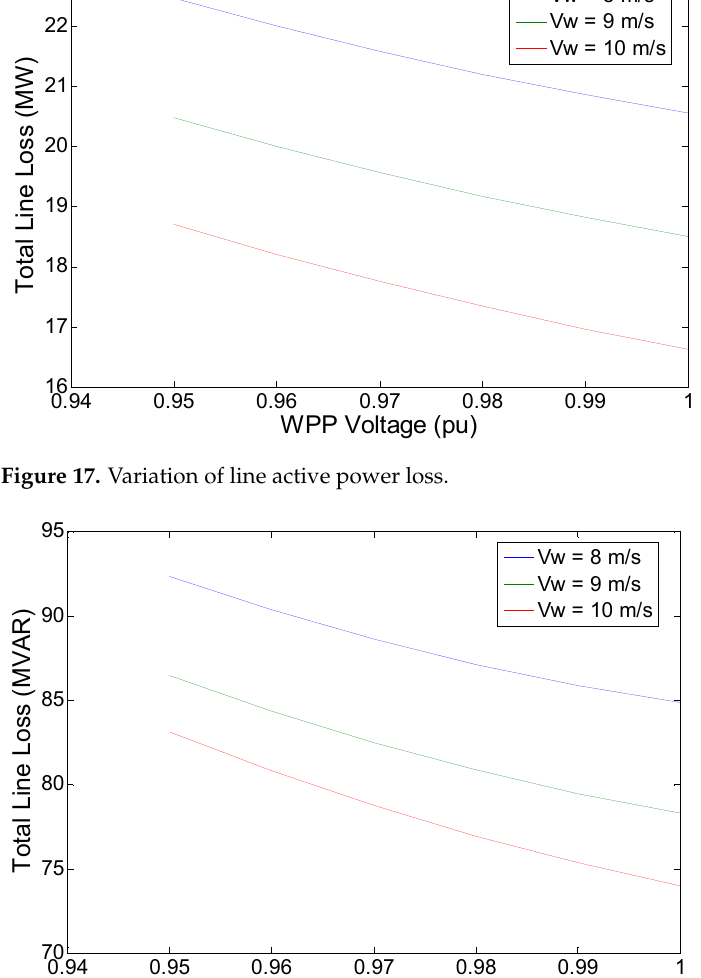
Figure 18. Variation of line reactive power loss.